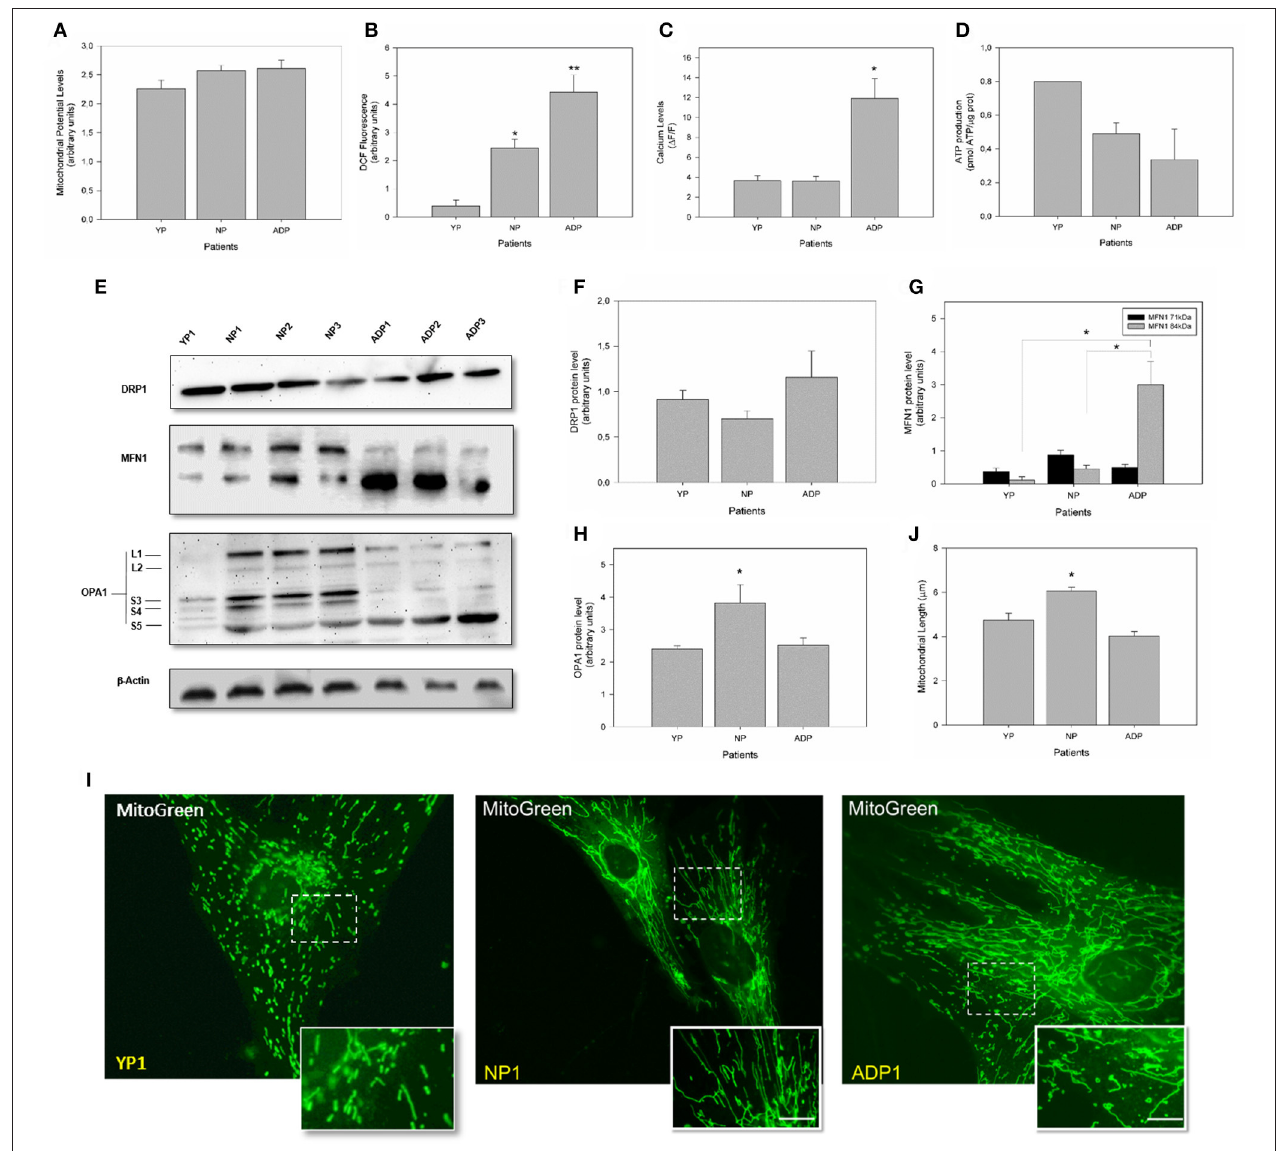
FIGURE 6 | Comparison of mitochondrial bioenergetics profile in young, healthy-aged and AD patient fibroblasts. (A) The graph represents the mitochondrial membrane potential levels as arbitrary units. Data are mean ± SE, n = 3 (technical replicates for each subject). (B) Quantification of total ROS levels in each patient as arbitrary units. Data are mean ± SE, n = 3 (technical replicates for each subject). *, ** p < 0.05 indicated differences with between groups calculated by one-way ANOVA test. (C) Cytosolic calcium levels after 1min treatment with thapsigargin. Data are mean ± SE. * p < 0.05 indicated differences between groups calculated by one-way ANOVA test. (D) Total ATP levels (pmol) normalized by µ g of protein. Data are mean ± SE, n = 3 (technical replicates for each subject). (E) Changes in the protein expression levels of DRP1, MFN1, and OPA1 were assessed by Western Blot in cell extracts from young, aged-match healthy and AD fibroblasts. A representative image of actin western blot is show as internal control (see additional data in Figure S1 ). (F) Quantitative analysis for DRP1 expression levels. Data are mean ± SE. (G) Quantitative data indicates splicing products for MFN1 expression. * p < 0.05 indicates differences between groups calculated by one-way ANOVA test, data are mean ± SE. (H) Quantification shows total OPA1 expression. * p < 0.05 indicate differences calculated by one-way ANOVA test, data are mean ± SE. (I) The mitochondrial length was visualized using a MitoGreen. Bar = 10 µ m. (J) Measurement of mitochondrial length (average) in all cell groups. Data are mean